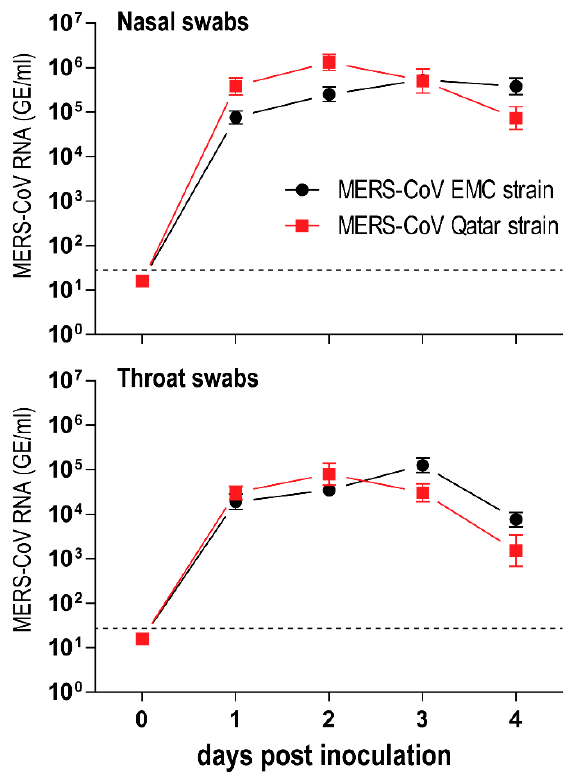
Figure 3. Middle East respiratory syndrome coronavirus (MERS-CoV) EMC strain and Qatar15 strain replicate equally in the upper respiratory tract of rabbits. Five New Zealand rabbits were each intranasally inoculated either with 1 mL of 1 × 10 6 TCID 50 / mL MERS-CoV EMC strain or Qatar15 strain. Nasal and throat swabs were obtained from day 0 (before inoculation) until day 4 post inoculation. The amount of viral RNA is displayed in genome equivalents per mL (GE / mL). Dashed lines depict the detection limit of the assay. All error bars represent standard deviations.